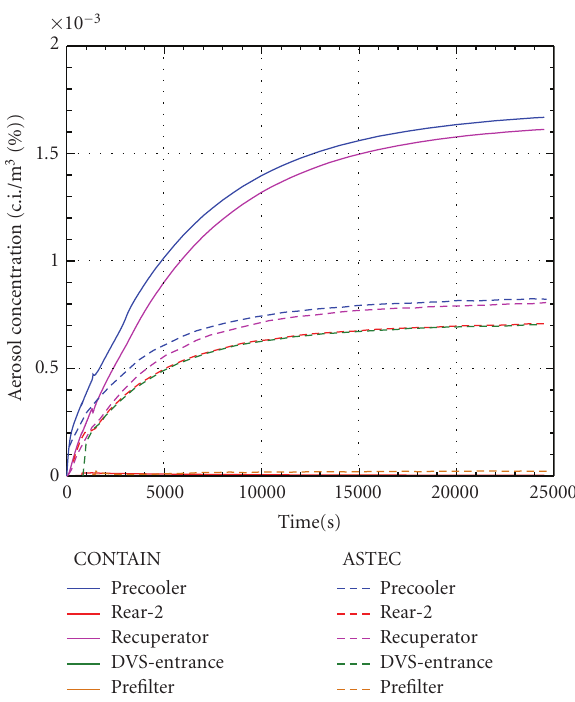
Figure 12: Airborne and deposited mass evolution in the confine- ment for the SB ASTEC CONTAIN (% of c.i.) (% of c.i.) 16.3 24.7